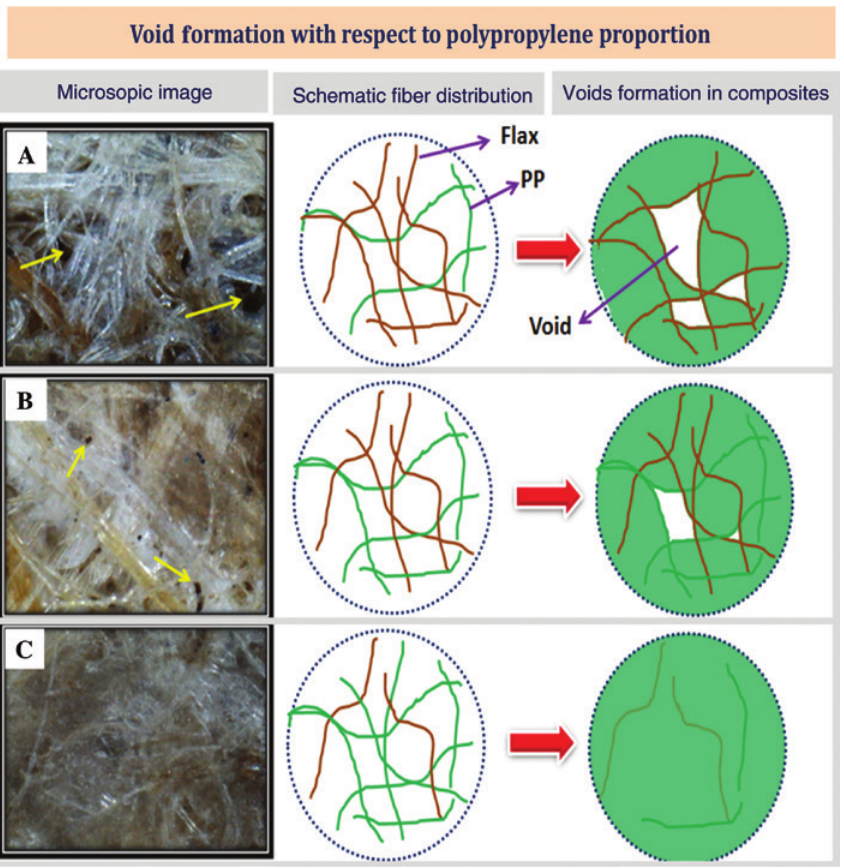
Figure 5: Optical microscope images of the prepared composites along with schematic sketch (20 ×